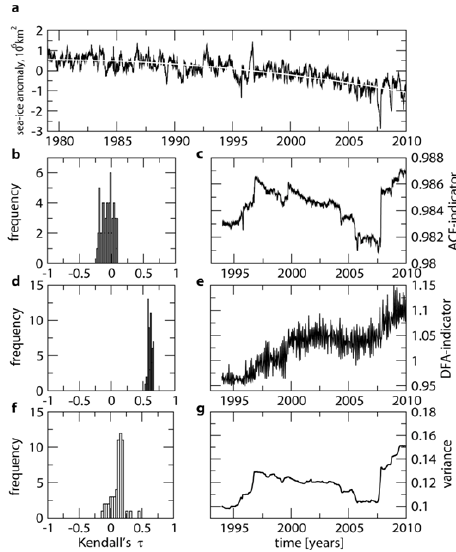
Fig. A3. Search for early warning signals of bifurcation in Arc- tic sea-ice extent data. (a) Sea-ice extent anomaly (as in Fig. A2a) showing the quadratic downward trend that is removed prior to cal- culating the instability indicators. Right panels show example indi- cators from (c) autocorrelation function (ACF), (e) detrended fluc- tuation analysis (DFA) and (g) variance, results plotted at end of a sliding window of length half the series. Left panels show his- tograms of the Kendall statistic for the trend in the indicators when varying the sliding window length from 1/4 to 3/4 of the series: (b) ACF-indicator; (d) DFA-indicator; (f) variance.